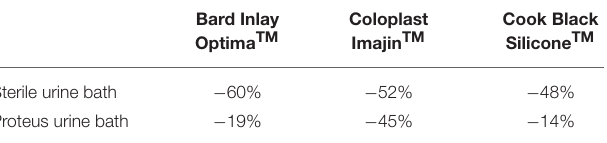
TABLE 1 | Differences in rates of combined calcium and magnesium encrustation for Tria TM Soft (Boston Scientific) ureteral stents compared to competitor stents at 2